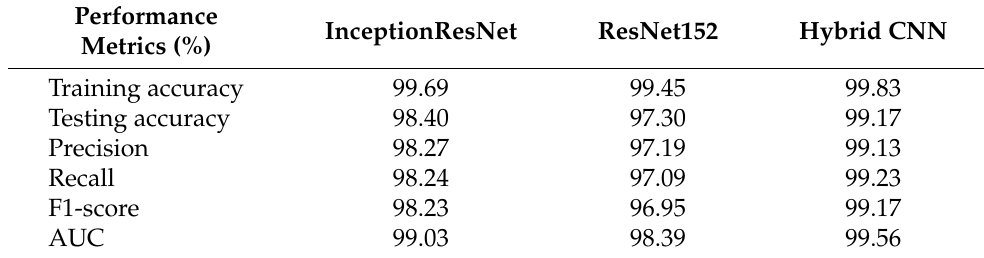
Table 5. Performance metrics of three